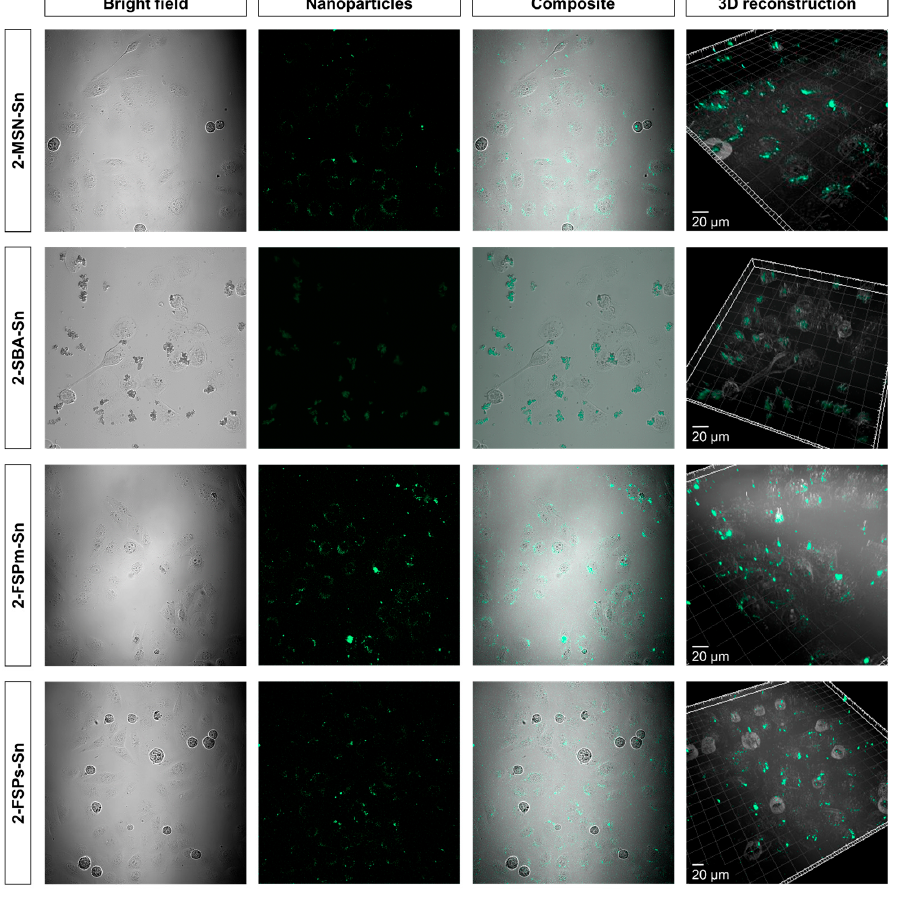
Figure 7. CLSM images of MDA-MB-231 cells incubated with 2-MSN-Sn , 2-SBA-Sn , 2-FSPm-Sn and 2-FSPs-Sn . Excitation wavelength 443 nm and emission wavelength 480 nm.